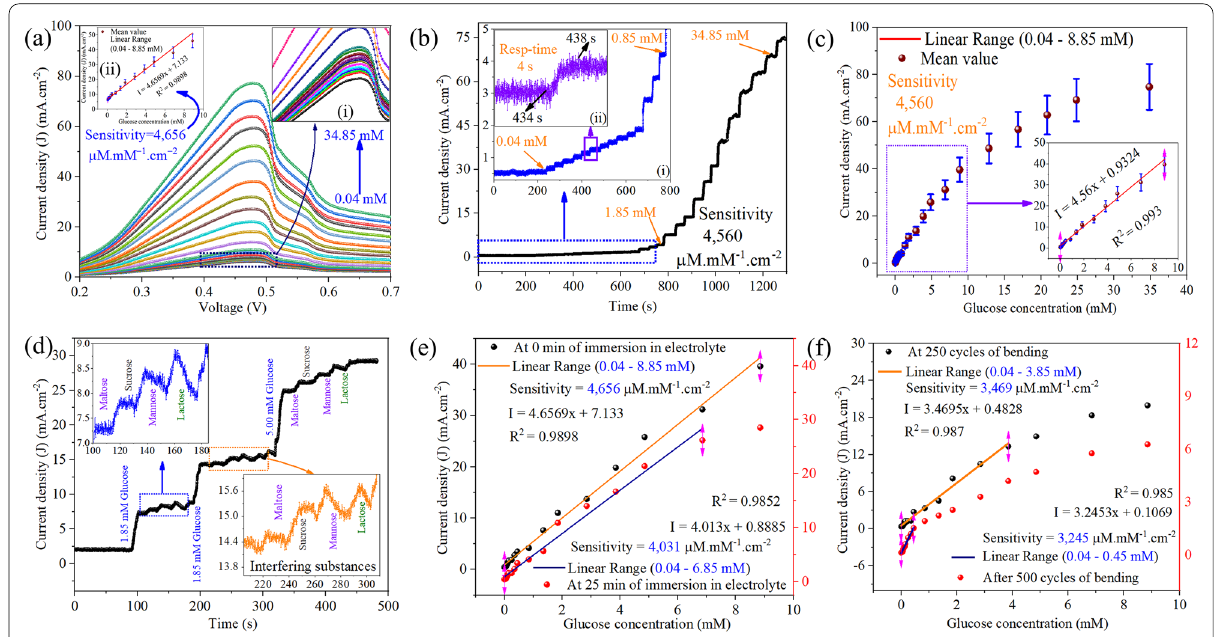
Fig. 6 I-V curve for glucose sensing performances of a CO/CZO heterostructure, where (inset-i) and inset (ii) show the enlarge of lower concentrated glucose enclosed with dash-blue rectangle and calibration plot of the linear range of 0.04 mM to 8.85 mM, respectively. b Amperometric responses to the glucose concentrations varies from 0.04 mM to 34.85 mM. Inset (i) is the enlarge view of the lower concentrated glucose enclosed with dash-blue rectangle and inset (ii) is the sensor response time determined to be 4 s. c The measured data and the calibration curve of the sensor’s amperometric response to the glucose concentration, each concentration was repeated four times and the error bars indicate the deviation. Insets plots show the linear relationship between the oxidation peak current and concentration of glucose in the range of 0.04 mM to 8.85 mM and the corresponding regression equation. d The amperometric response curve of the sensing electrode to the addition of interfering agents: lactose, maltose, mannose, sucrose, and glucose in the solution. Variation in sensitivity with e mechanical deformation of 500 cycles and f immersion in electrolyte for 25